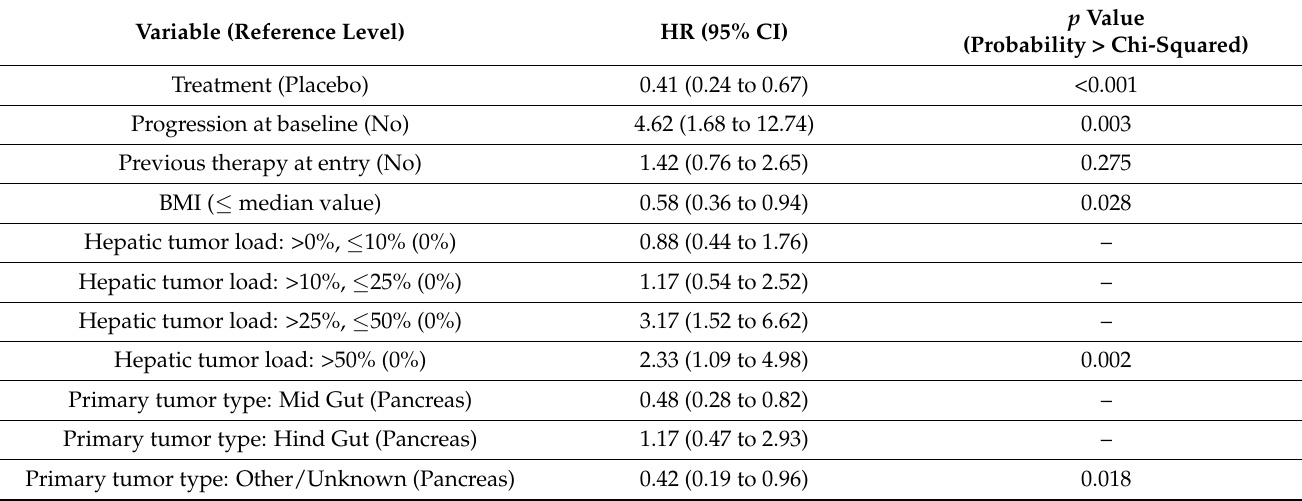
Table 3. Exploratory analysis into the influence of baseline covariates on PFS time, final model (intention-to-treat